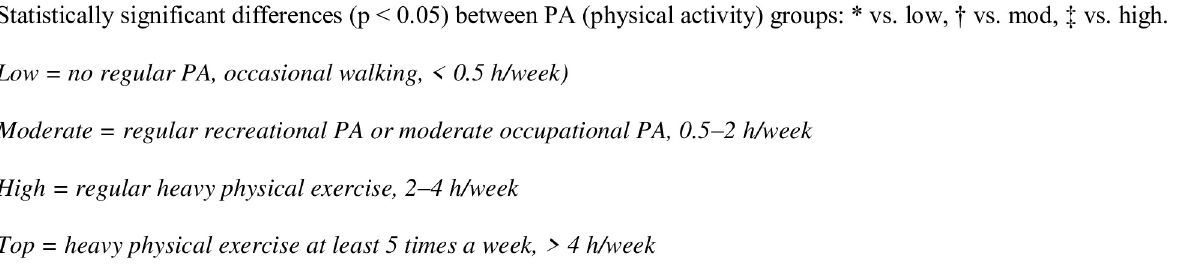
Fig 1. The mean (SD) HRV values according to physical activity level in young men (n = 3395).